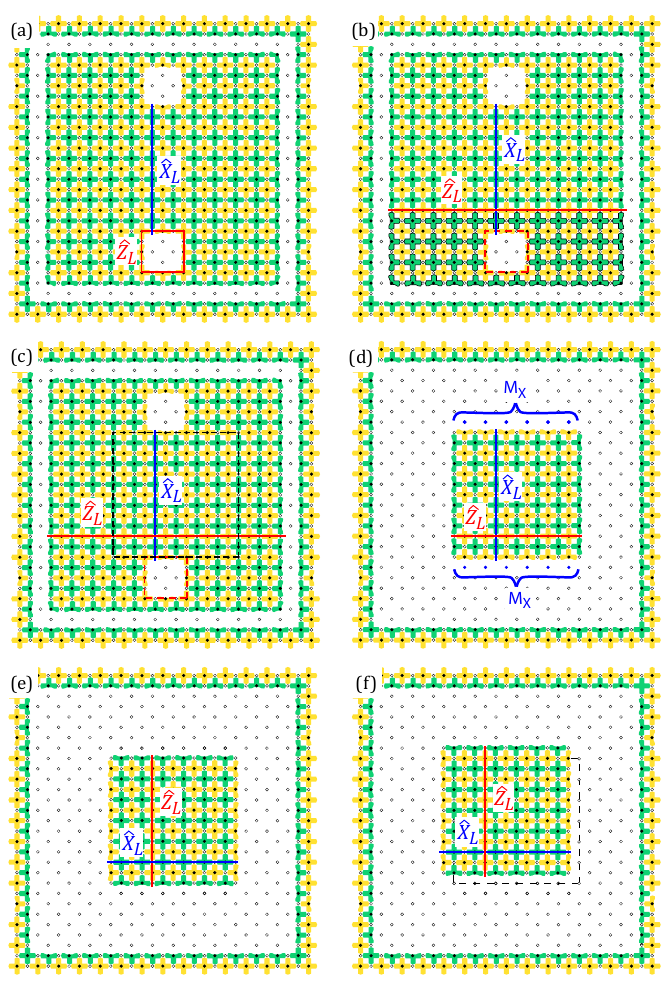
Figure 42: (a) In the first cycle, a ring of X stabilizers surrounding the target qubit is turned off, and the bordering Z stabilizers reduced to three- and two-terminal measurements. The data qubits within the ring are measured in the Z basis to maintain error tracking. This mea- surement pattern is applied three times (see Ref. (Fowler, Mariantoni, Martinis and Cleland, 2012a)). (b) The Z operator is multiplied by all the black outline Z stabilizers, transforming L Z to the chain going from left to right. (c) In the next cycle, all X and Z stabilizers outside L the dashed box are turned off, creating a “moat” as in (d), eliminating the two qubit holes. In the same cycle, all isolated data qubits are measured in Z , except those colored blue (light), which are measured in the X basis to preserve error tracking. The other un-stabilized data qubits do not need to be measured, as changes in their quantum states will be accounted for later. (e) Before the next surface code cycle starts, a physical Hadamard is performed on all data qubits, swapping X and Z . (f) Following the Hadamard, a pair of swaps is performed L L between each patch data qubit and its neighboring measure qubits, first between each data qubit and the measure qubit above it, then between each measure qubit and the data qubit to its left. This shifts the patch by one stabilizer cell in the array, aligning the measure qubits. The dashed box shows the location of the patch prior to these swaps. This sequence continues in Fig. 43. Figure from Ref. (Fowler, Mariantoni, Martinis and Cleland,